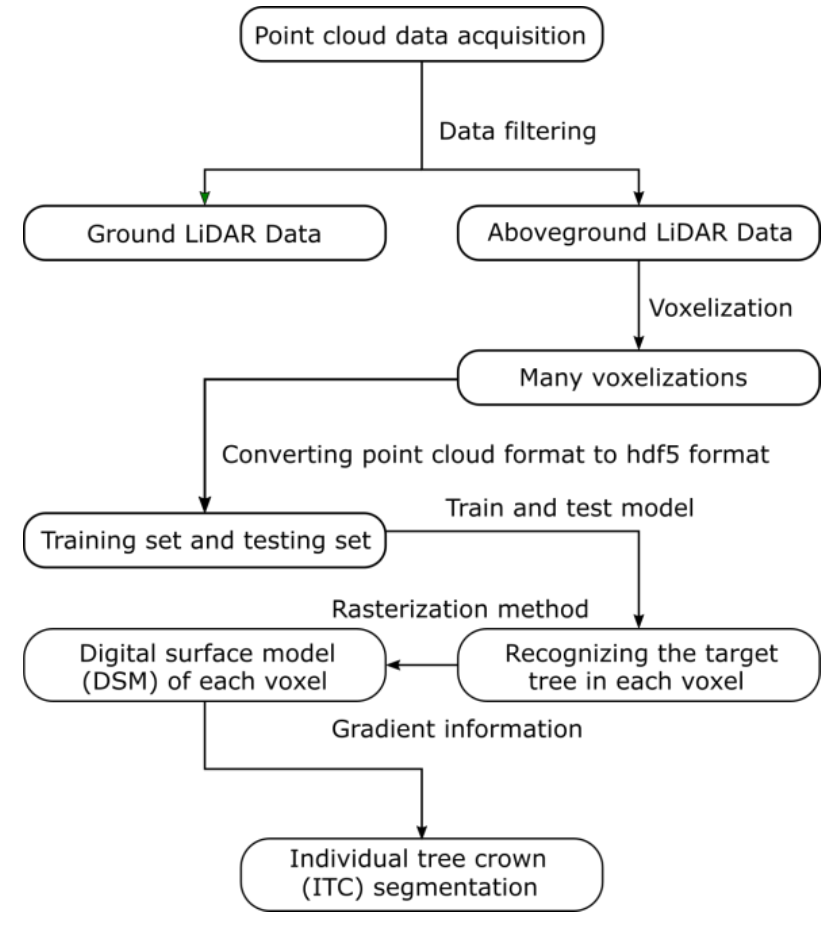
Figure 1. The main steps for our individual tree segmentation based on the deep learning method.